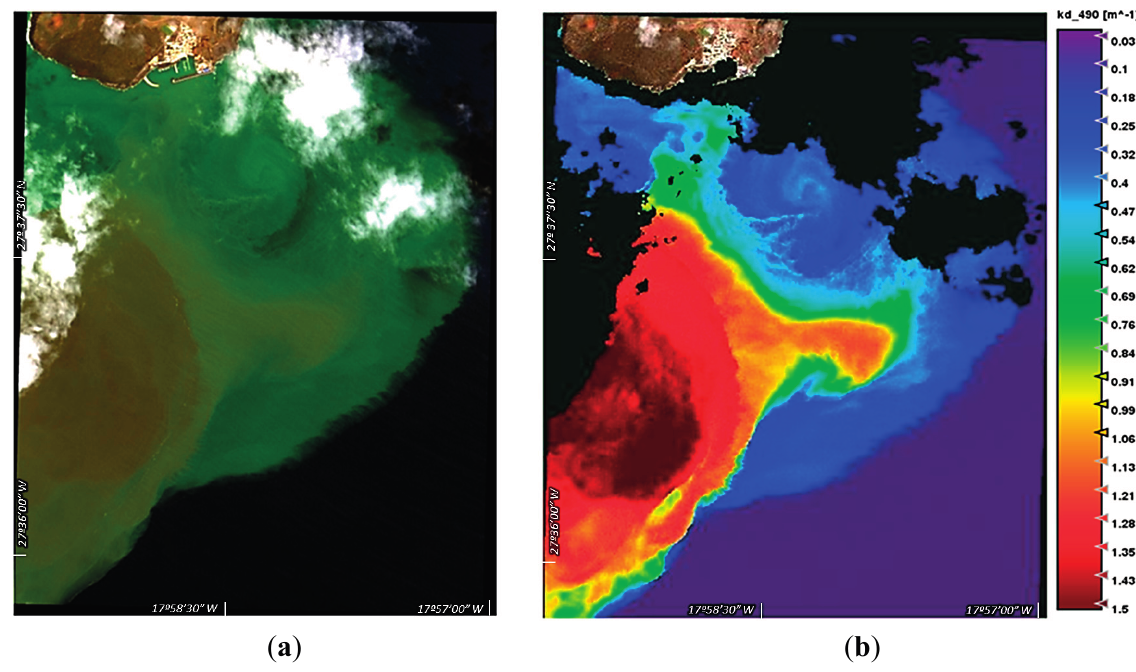
Figure 3. Worldview-2 image of October 26, 2011: ( a ) colour composite (bands 5-3-2) and ( b ) very high resolution diffuse attenuation coefficient map (clouds masked in